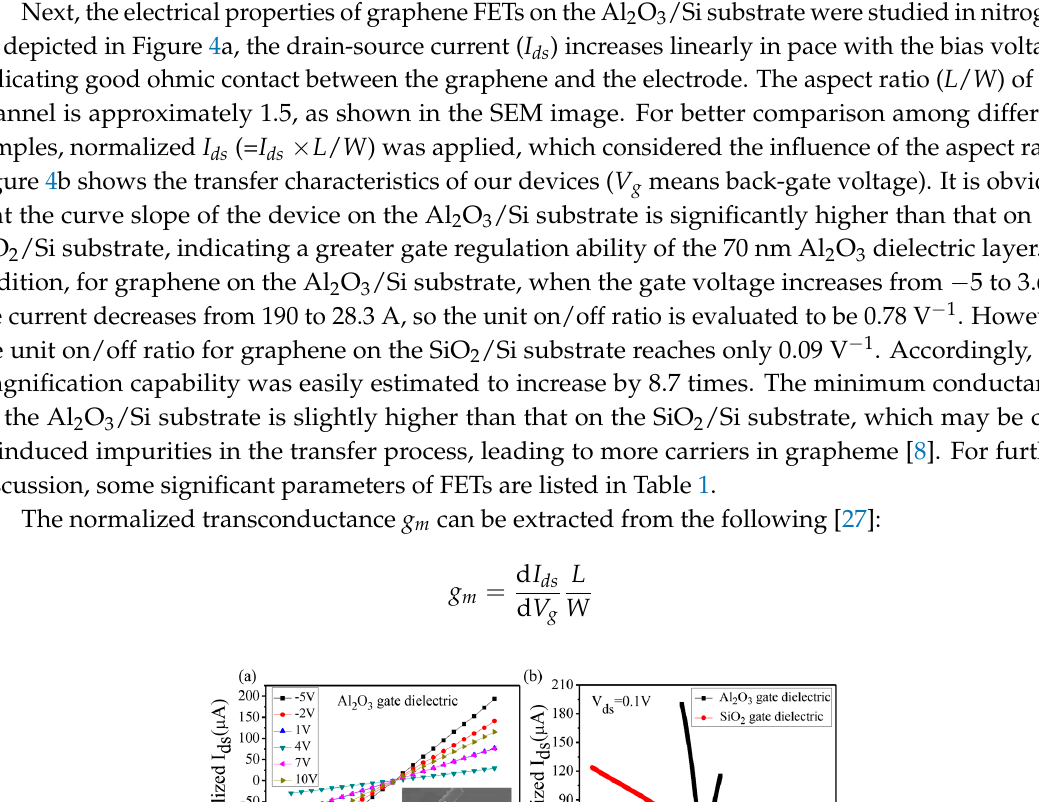
Figure 4. ( a ) Output characteristics of graphene FETs on the Al 2 O 3 /Si substrate at different gate voltages ( − 5~10 V). The inset shows an SEM image of the device. ( b ) Transfer characteristics of graphene FETs on different substrates.